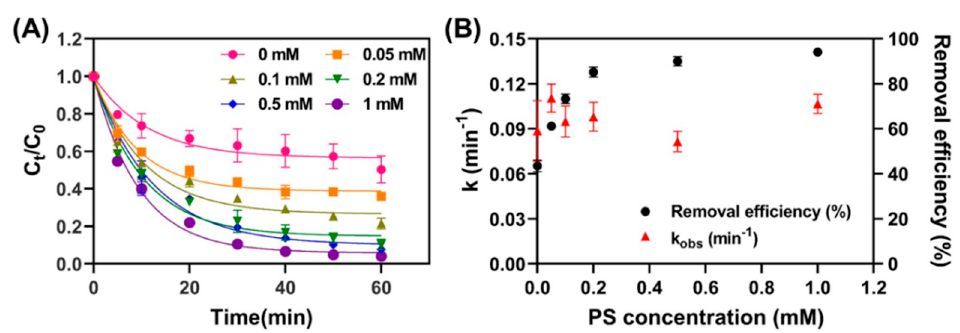
Figure 5. ( A ) Plotted TC removal efficiency versus PS concentration ([Fe 3 O 4 ] = 1.0 g/L; [PS] = 1.0 mM; [TC] = 41.6 µ M; pH = 4.8), and ( B ) plotted reaction rate coefficient against PS concentrations.